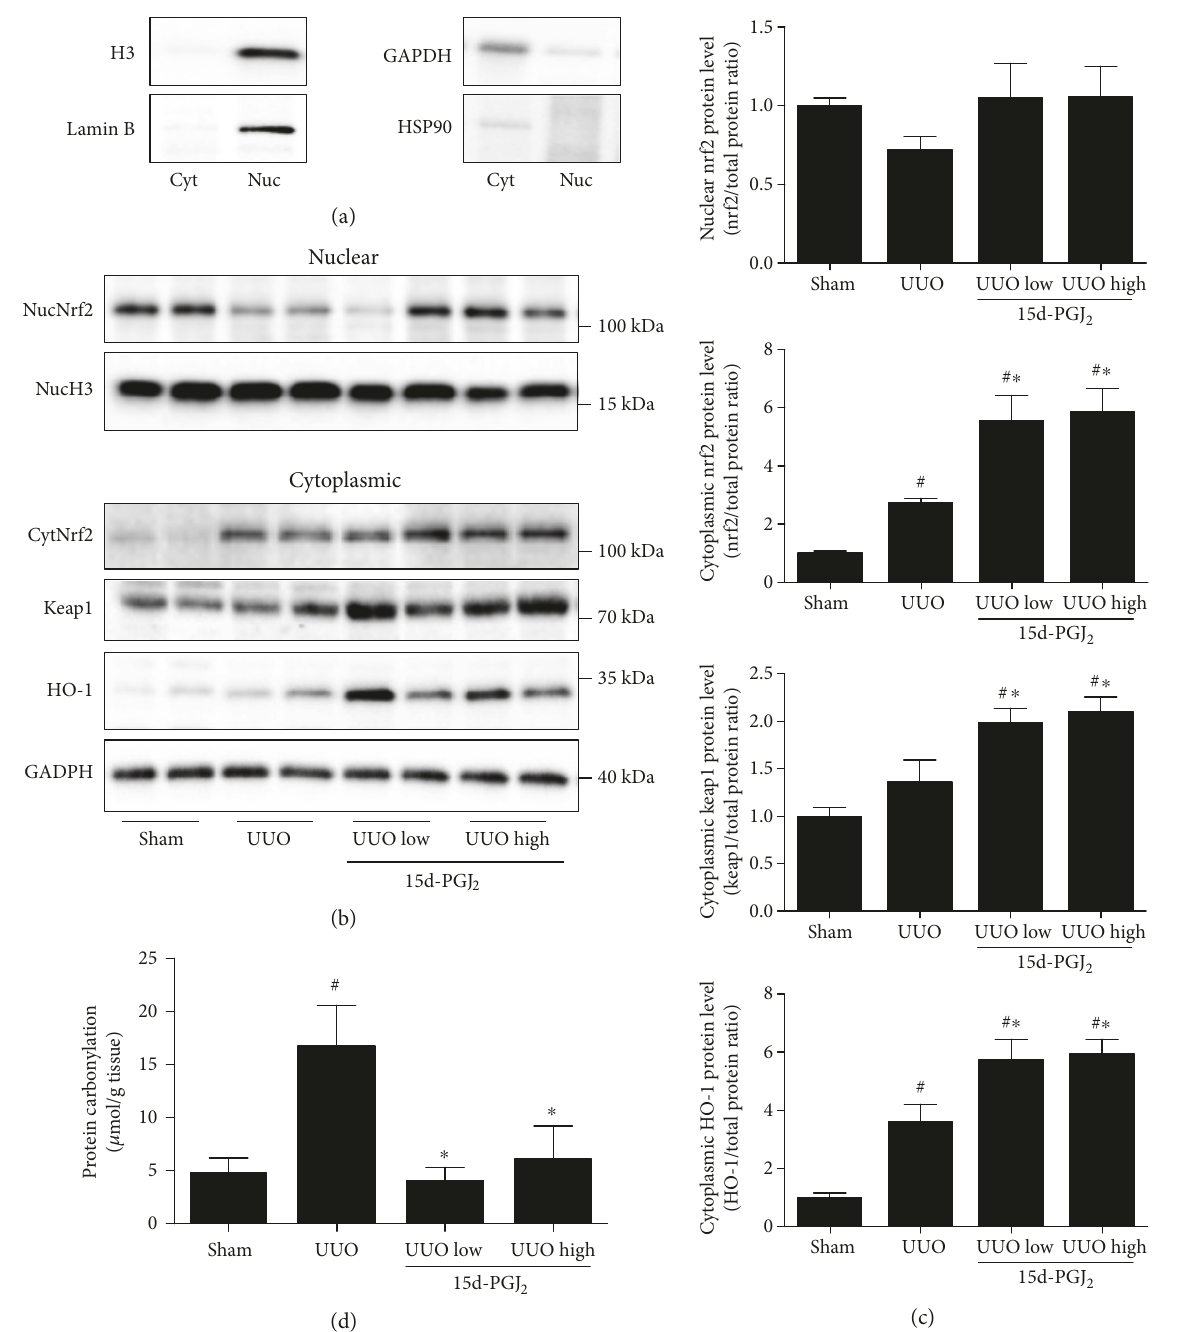
Figure 1: E ff ects of 15d-PGJ on the regulation of Nrf2 localization and antioxidants in the kidney cortex during 3-day UUO. (a) Veri fi cation 2 of the purity of nuclear and cytosolic extracts. Nuclear markers, histone H3 and Lamin B, as well as cytosolic markers, HSP90 and GAPDH, were used to show the purity of the tissue extracts. (b-c) Nuclear protein extracts were used to analyze Nrf2 nuclear (Nuc) expression. Cytosolic (Cyt) Nrf2, Keap1, and HO-1 proteins were further analyzed in the cytosolic fraction. Representative western blots are shown. (d) Protein carbonylation. Proteins were extracted from cortical tissue and analyzed using 2,4-dinitrophenylhydrazine to quantitate carbonyl content as a marker of protein oxidation. 15d-PGJ was administered at a low (0.5 mg/kg/day) and a high (1 mg/kg/day) dose as 2 depicted in each graph. Data represents mean ± SEM. # P < 0 05 versus that in sham; ∗ P < 0 05 versus that in UUO, using ANOVA and Bonferroni ’ s post hoc test ( n = 5 , sham; n = 6 , UUO groups). Histone H3 (Hist. H3) and GAPDH are shown as loading controls for nuclear and cytoplasmic protein extracts, respectively. UUO, unilateral ureteral